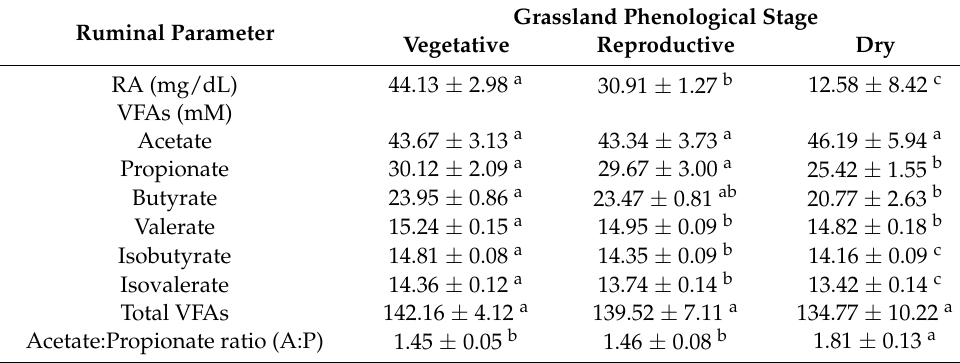
Table 1. Concentration of ammonia (RA, mean ± standard deviation) and volatile fatty acids (VFAs, mean ± standard deviation) in grazing sheep ruminal fluid in each grassland phenological stage at the experimental